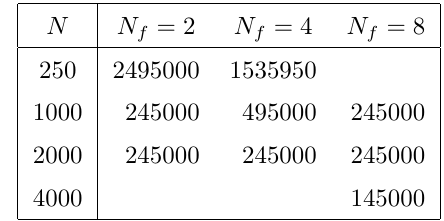
Table 3 . Number of independent Monte Carlo con(cid:12)gurations used in section